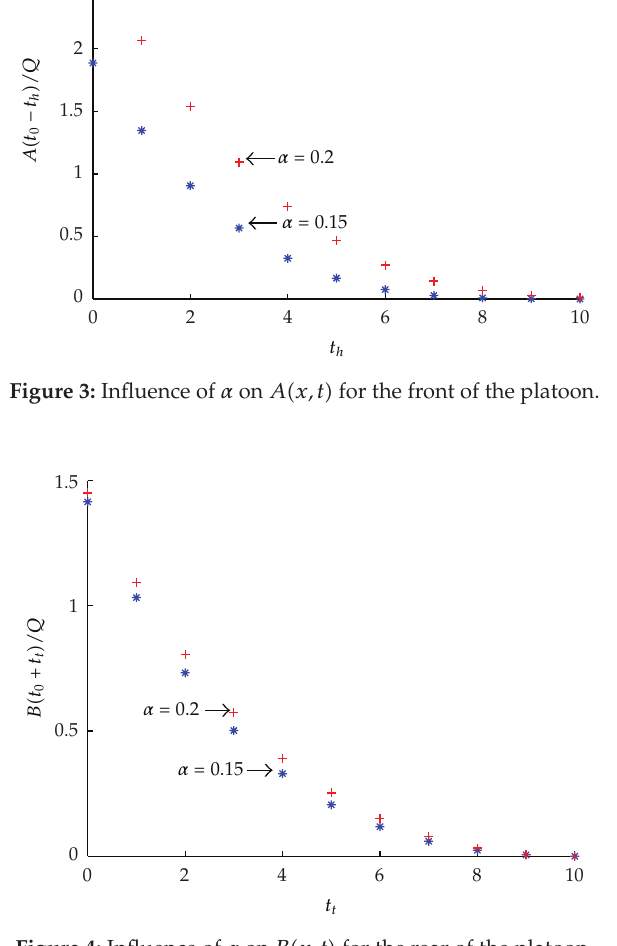
Figure 4: Influence of α on B (cid:6) x,t (cid:7) for the rear of the